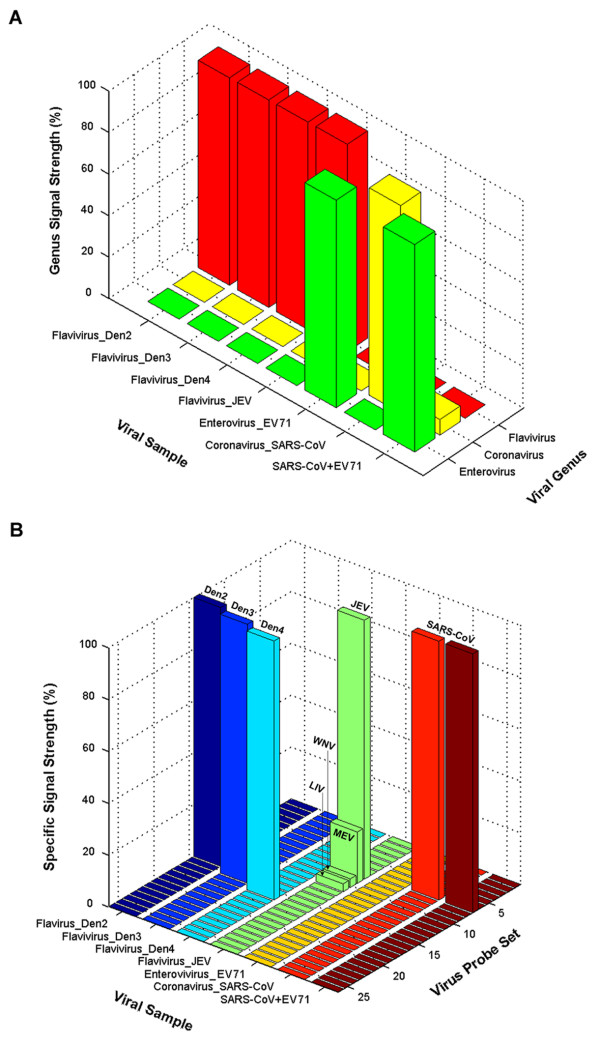
Viral genus classification and specific virus identification. Hybridization and identification results for seven test viral samples. The probes eligible for identity determination were prescreened using the hybridization intensity criteria described in the Methods section. (A) Viral genus determination for the seven viral samples, all of which belong to three viral genera. The genus signal strength is defined in the Methods section. (B) Determination of the identities of specific viruses. The numbers on the Y-axis are the ID numbers of the virus targets as listed in Additional File 2. Note that there are 46 species-specific probes for 26 viruses in the flavivirus and coronavirus genera, and that there are no enterovirus-specific probes.